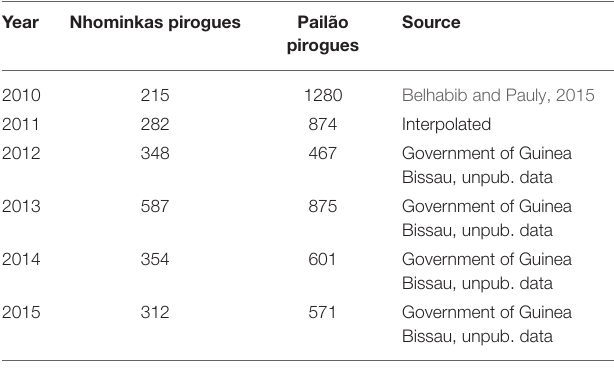
TABLE 3 | Artisanal fishing effort in Guinea Bissau, 2010–2015.